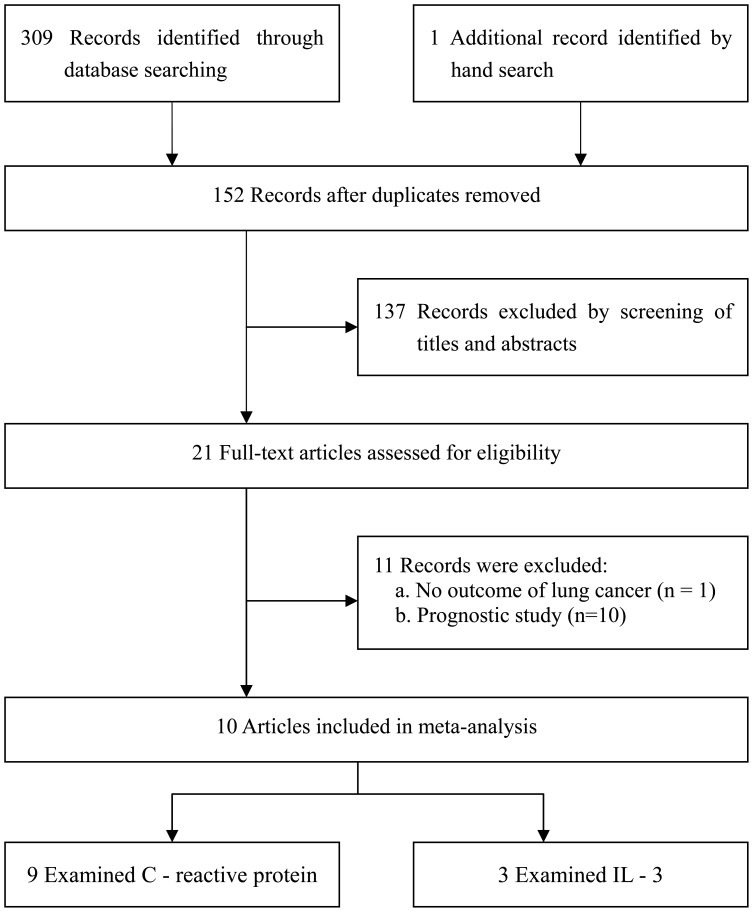
Flow diagram of study identification.